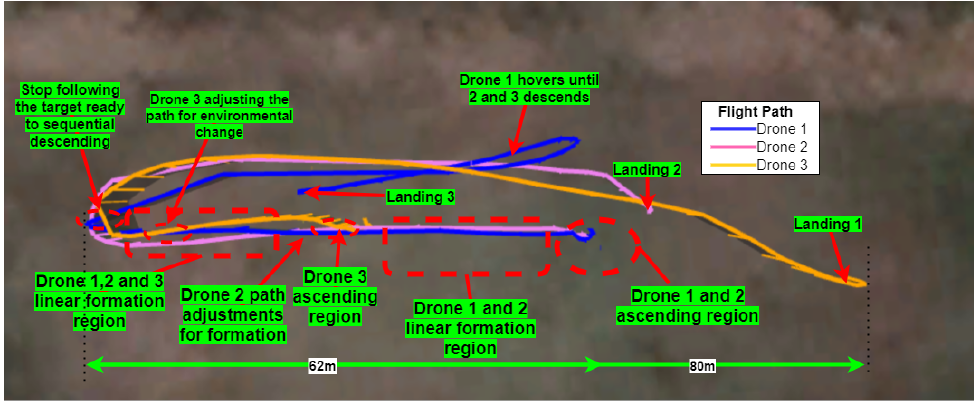
Figure 16. Top view of flight